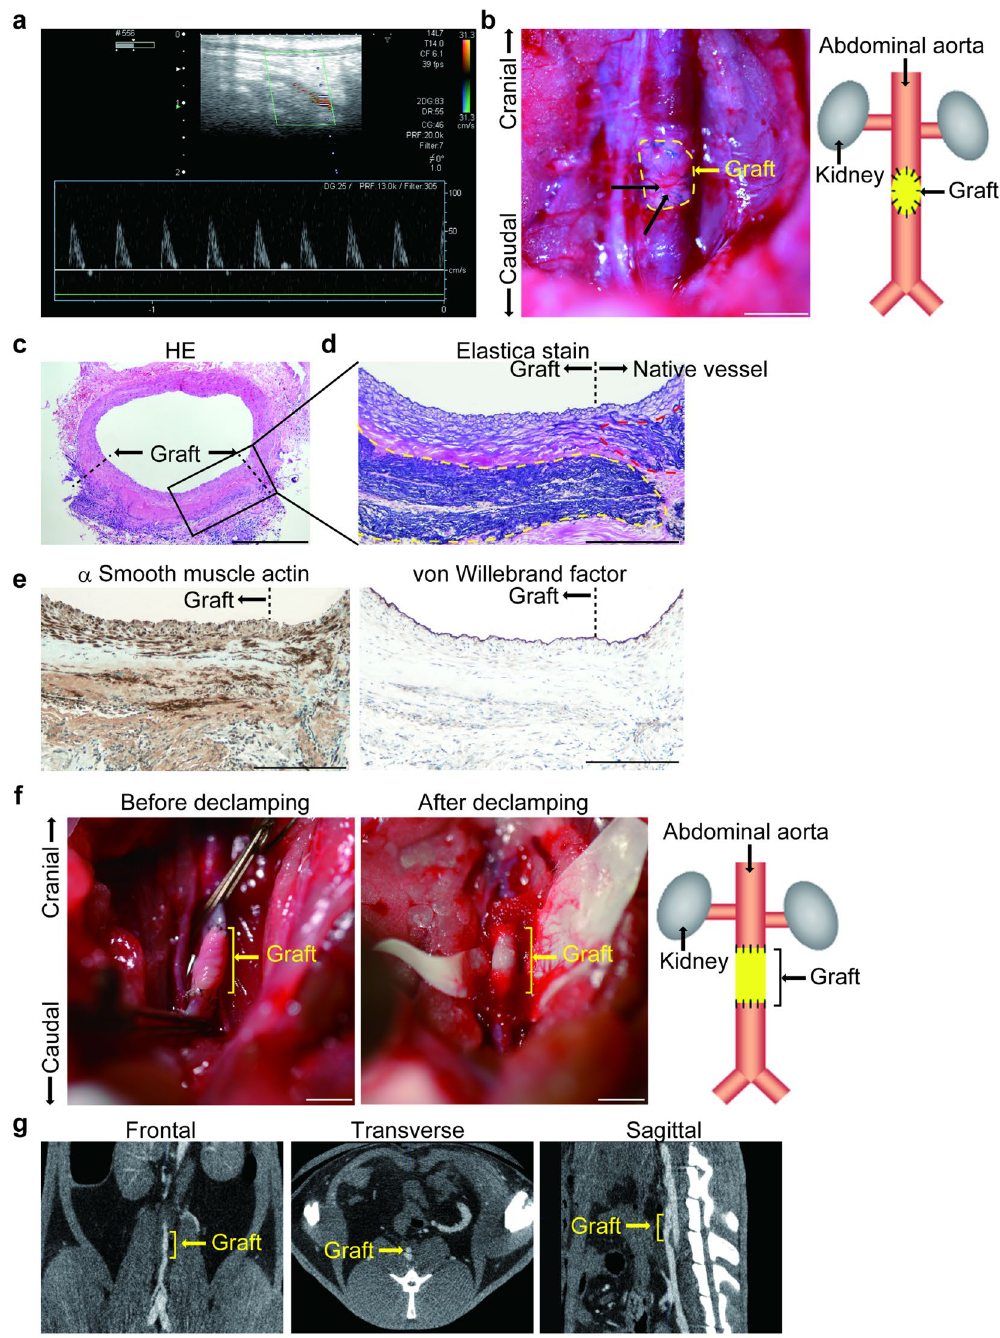
Figure 8. Implantation of medial grafts into rat abdominal aorta. ( a ) An oval shape of patch graft measuring 2.0 mm by 1.5 mm was sutured at an adult rat abdominal aorta in which the same size of aortic tissue was completely resected. Doppler echocardiography detected a non-stenotic flow pattern below the implantation site 2.5 months after implantation. ( b ) A patch graft implanted into the rat abdominal aorta is shown as a yellow dotted line. Arrowheads indicate capillary vessels on the surface of the patch graft. Scale bars: 2 mm. ( c ) An HE stain image of rat abdominal aorta implanted with a patch graft. Hitological data were obtained 2.5 month after implantation. The dotted lines indicate the area of the patch graft and the rest is native aortic tissue. Scale bar: 500 μ m. ( d ) An elastica van Gieson stain image of the indicated area of ( c ). The black dotted line indicates a junction between a patch graft and native aortic tissue. The yellow and red black dotted lines indicate a patch graft and native aortic tissue, respectively. ( e ) Immunohistochemistry of α -smooth muscle actin and von Willebrand factor at the same area of ( d ). Scale bars of ( c – e ): 200 μ m. ( f ) A tubular medial graft was implanted into a rat abdominal aorta. Scale bars: 2 mm. ( g ) Computed tomography (CT) scanning one day after surgery demonstrated the patency of the tubular medial